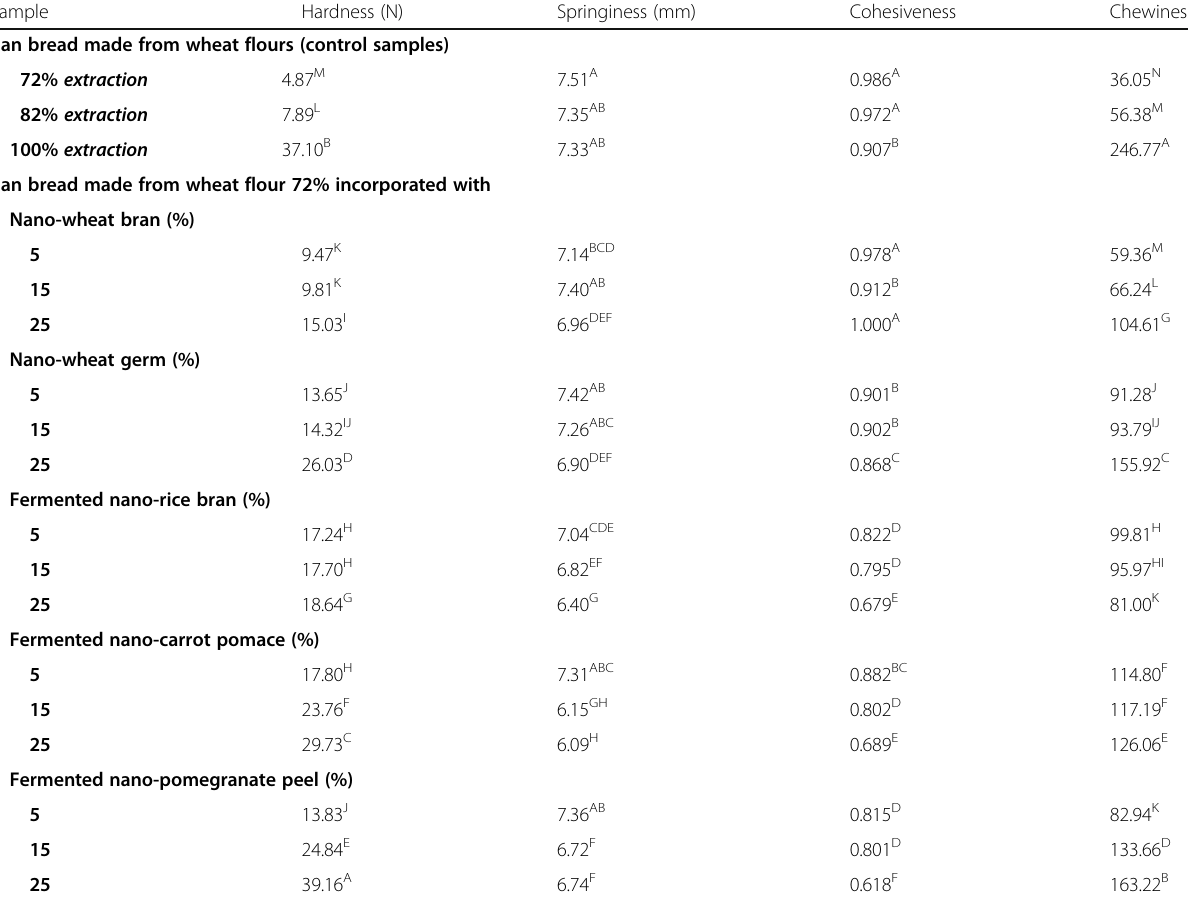
Table 3 Texture profile parameters of pan bread as affected by addition of nano and fermented nano materials